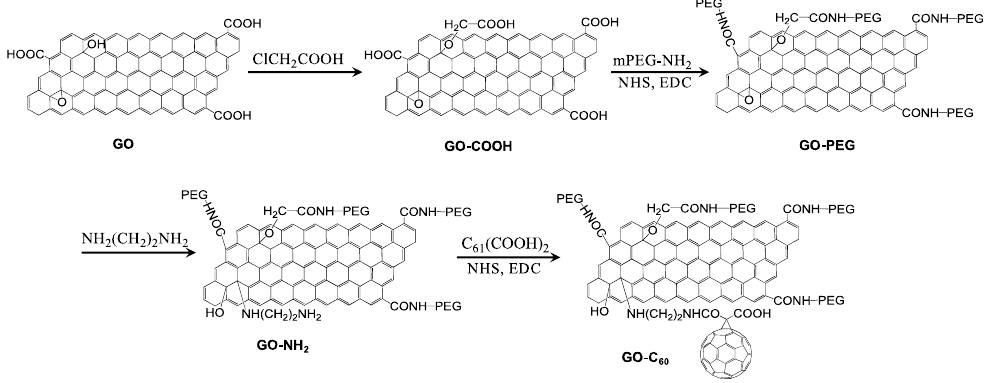
Figure 11. Synthesis of GO-C 60 . Image adapted with permission from [157].